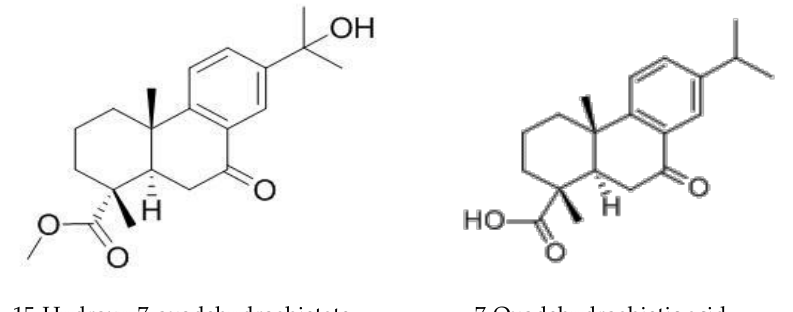
Figure 11. Abietane type diterpenids from Pinus densiflora.